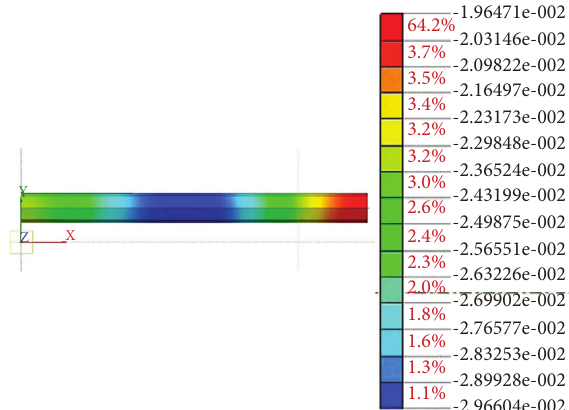
Figure 11: Pipeline deformation cloud map.